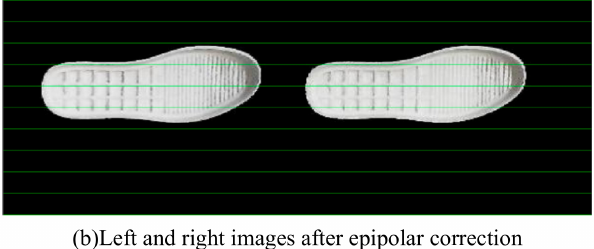
Figure 4. Images before and after epipolar